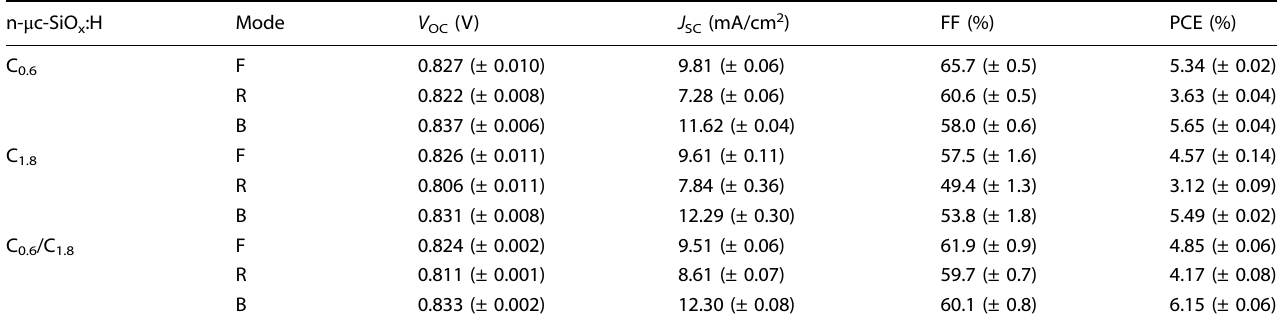
Table 2. Performance parameters (averages and standard deviations determined for eight cells) of T-CPI cells prepared using an etching time of 2 min and different n- μ c-SiO x :H formation conditions (F: front irradiance, R: rear irradiance, B: bifacial irradiance). n- μ c-SiO x